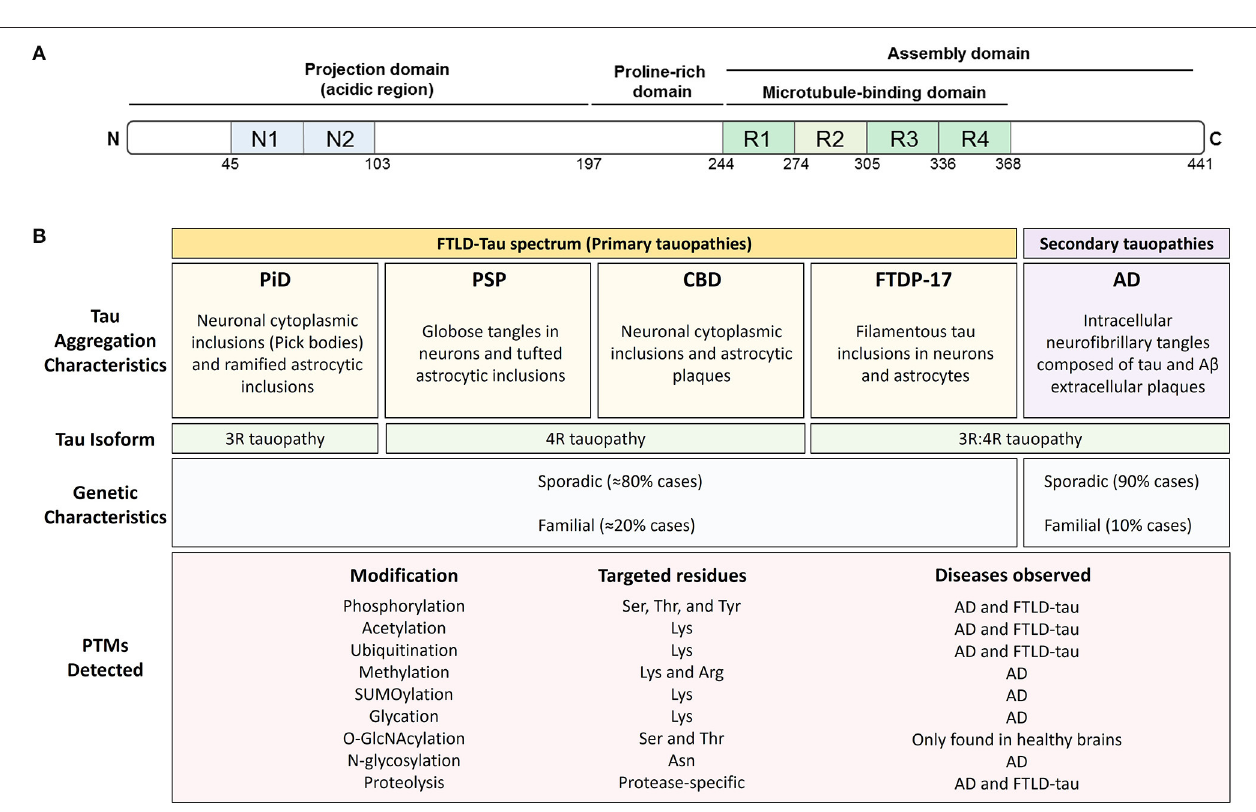
FIGURE 1 | Post-translational modifications are found throughout tau and associate with all tauopathies. (A) Schematic representation of the structural features of 2N4R tau protein. Tau exists in 6 isoforms generated by the alternative splicing of exons 2, 3, and 10 of the MAPT gene. The isoforms include 0, 1, or 2 amino-terminal inserts (blue rectangles) and three (3R) or four (4R) microtubule-binding potential repeat domains (green rectangles). (B) Pathological and genetic classification of tauopathies as they relate to post-translational modifications (PTMs). Primary tauopathies fall under the umbrella pathological term frontotemporal lobar degeneration with tau inclusions (FTLD-Tau) and include Pick’s disease (PiD), progressive supranuclear palsy (PSP), corticobasal degeneration (CBD), and frontotemporal dementia with parkinsonism (FTDP-17). Alzheimer’s disease, a secondary or mixed tauopathy, is characterized by the presence of extracellular inclusions containing Amyloid β (A β ) protein. Tauopathies are also classified depending on tau isoform composing the intracellular inclusions. PiD is a 3R-predominat tauopathy, PSP, and CBD are 4R tauopathies and FTDP-17 and AD are 3R:4R tauopathies. The PTMs observed in tau, the targeted residues and the disease where they have been observed is also